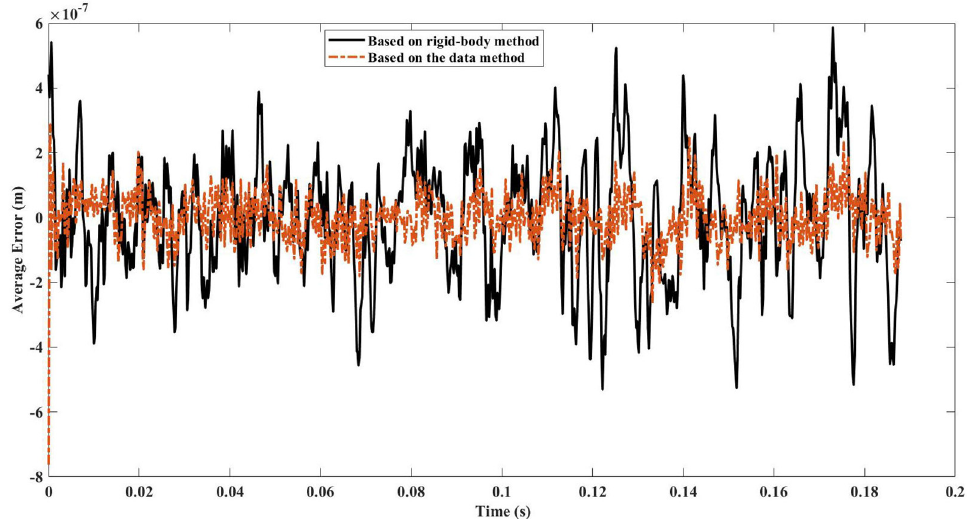
Fig. 13. Average error of the fi ve group